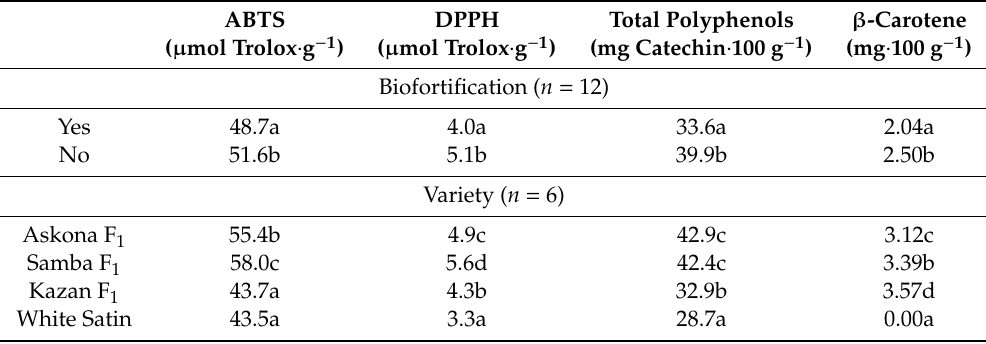
Table 2. Antioxidant activity of carrot juices depending on carrot biofortification and their varieties (results for fresh weight).